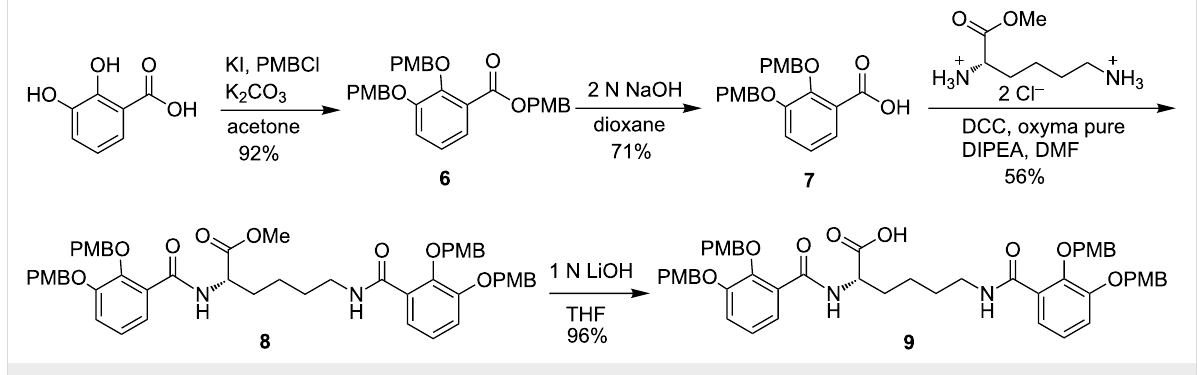
Scheme 2: Synthesis of the azotochelin siderophore